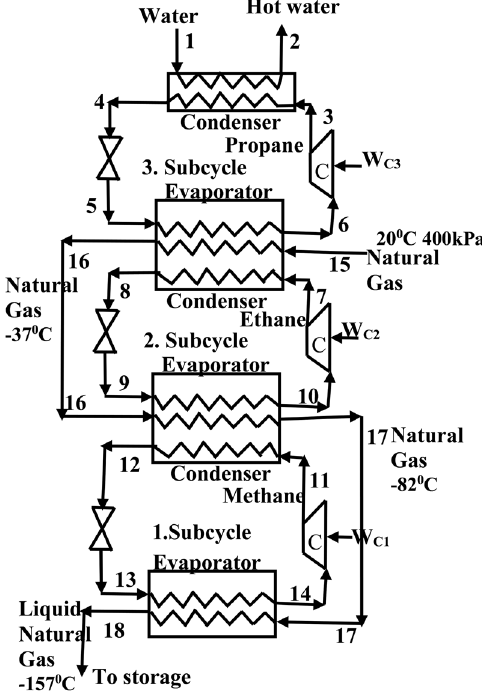
Figure 2: Three - stage vapor compression cascade cryogenic